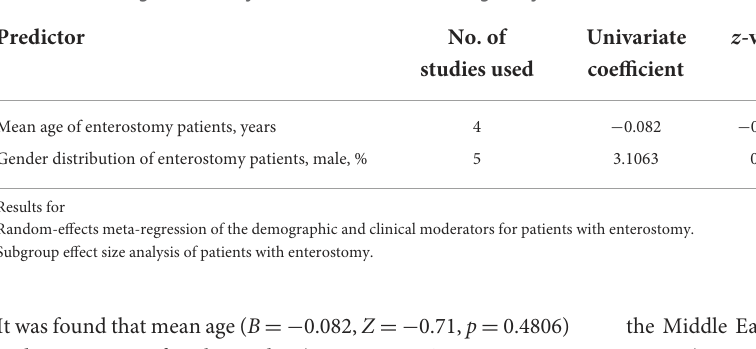
TABLE 2 Meta-regression analysis on the sources of